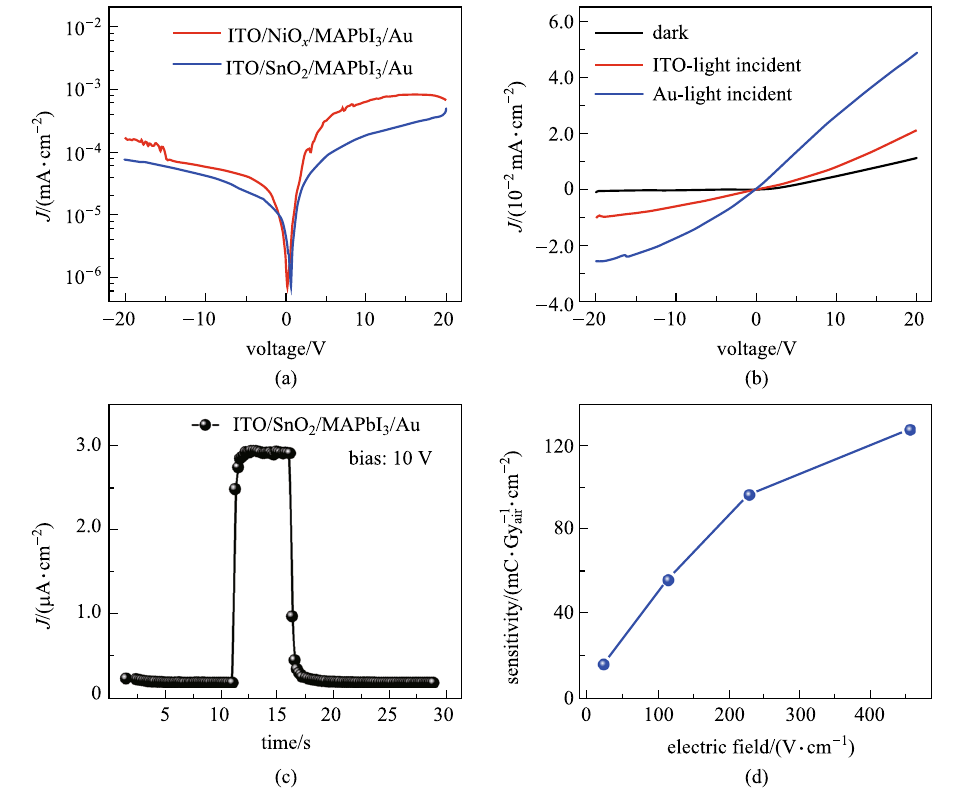
Fig. 5 Detection performance of MAPbI J−V curves of the X-ray detectors with SnO 3 thick films. a 2 and NiO x layer. b Visible light response- voltage characteristics at both surfaces for the ITO/SnO 2 /MAPbI 3 /Au device. c X-ray response, with the electric field set as 238 V/cm. d Sensitivity as a function of the electric